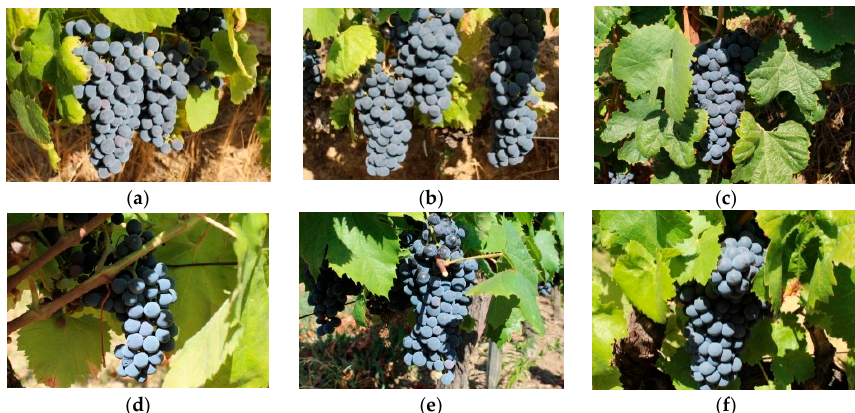
Figure 2. A sample of each one of the six red grape varieties of the Douro Red Grape Variety (DRGV) database: ( a ) Touriga Nacional , ( b ) Tinta Roriz , ( c ) Touriga Franca , ( d ) Tinto Cão , ( e ) Tinta Barroca, and ( f ) Tinta Amarela .